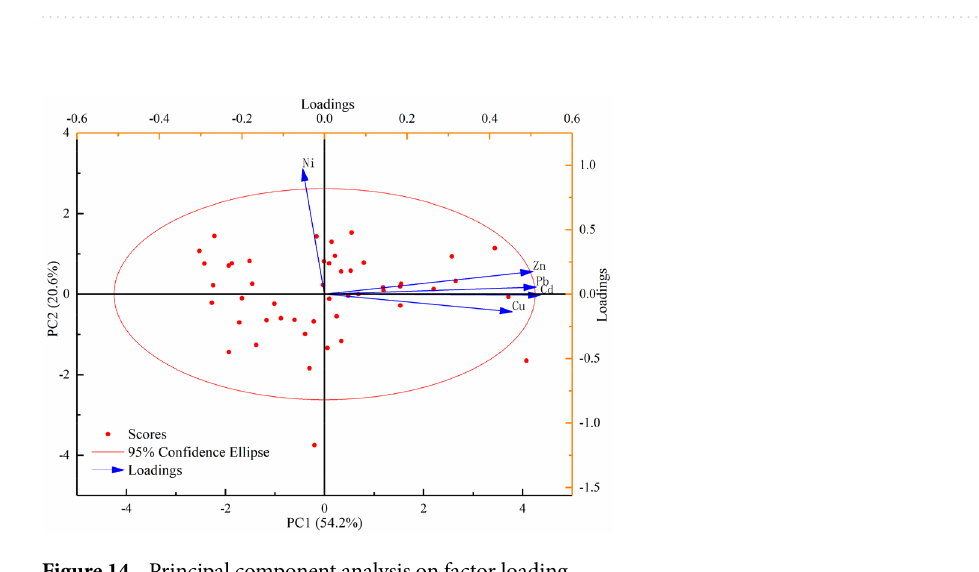
Table 7. Matrix analysis matrix of soil heavy metals in the researched area.